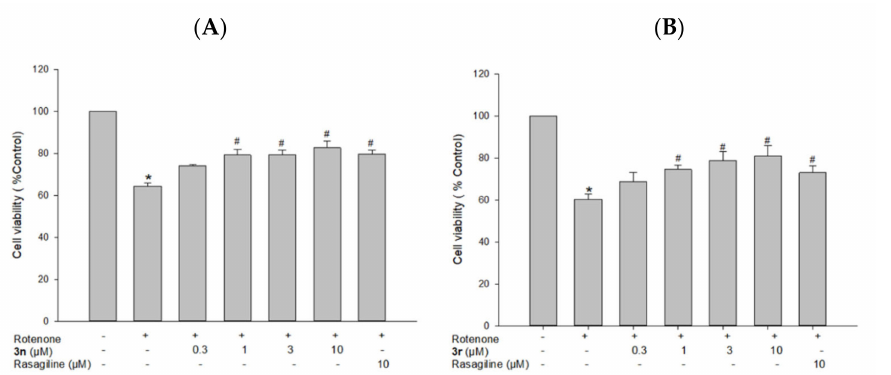
Figure 13. Neuroprotective effects of compounds 3n ( A ) and 3r ( B ) on rotenone-induced toxicity in PC12 cells. PC12 cells were pre-treated with the test compounds or rasagiline at the indicated concentrations for 4 h and exposed to rotenone (1 µ M) for an additional 24 h. Cell viability was evaluated by MTT assay as described in the Materials and Methods section. Data are expressed as the mean ± SEM of at least three independent experiments. * p < 0.05 and # p < 0.05 vs. the vehicle-treated control and rotenone-treated cells, respectively.